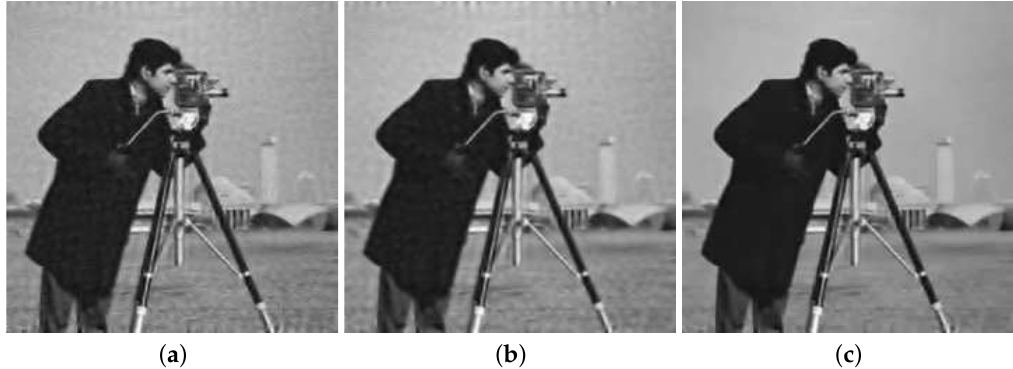
Figure 4. Cameraman test problem reconstructions: ( a ) ISTA, ( b ) PISTA h , ( c ) Struct-PISTA h